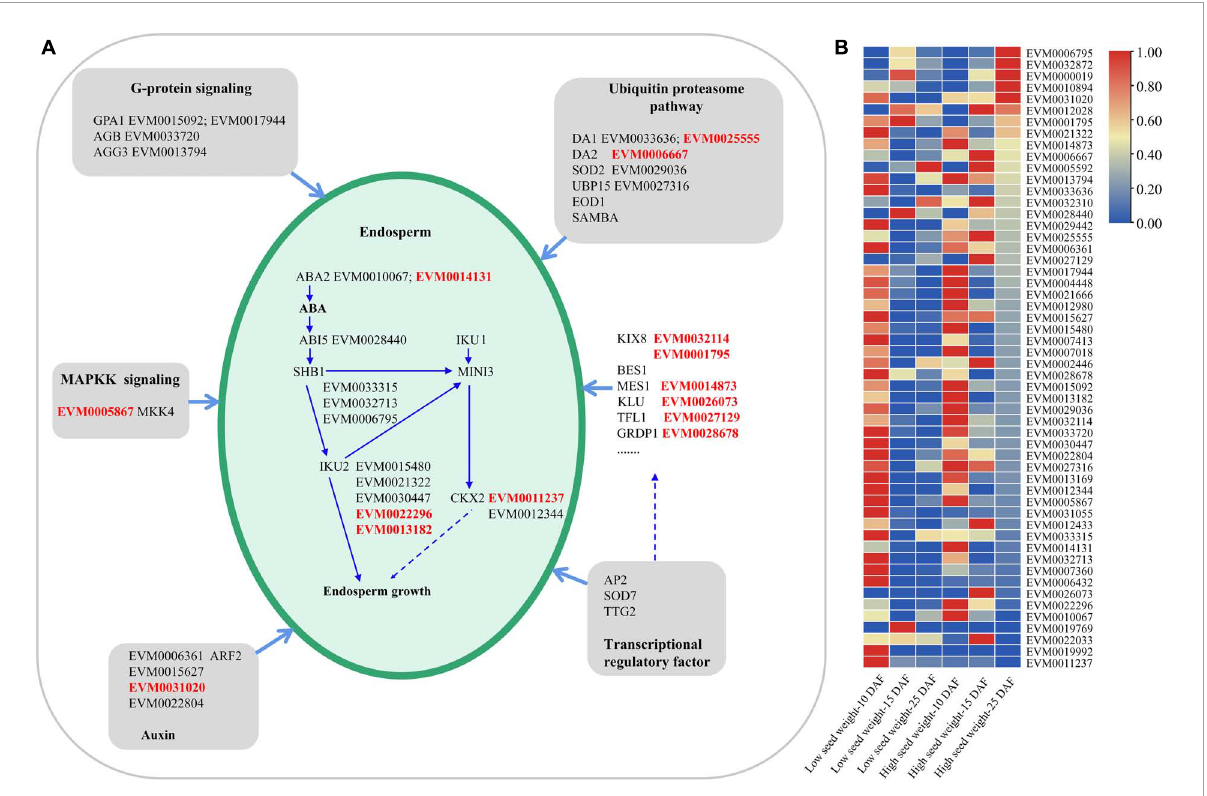
FIGURE6 The seed development pathway in mungbean (A) and the expression profiling of 54 candidate genes predicted by comparative genomics, identified in this study (B) . GPA1, G PROTEIN ALPHA SUBUNIT 1; AGB, heterotrimeric G-protein beta subunit; AGG3, heterotrimeric G-protein gamma-subunit; DA1/DA2, a ubiquitin-activated peptides; SOD2, chloroplastic copper/zinc superoxide dismutase CSD2; EOD1, E3 ubiquitin ligase; UBP15, ubiquitin-specific protease; SAMBA, plant-specific negative regulator of the APC/C complex; MKK4, mitogen-activated map kinase; ABA2, ABA DEFICIENT 2; ABI5, ABA INSENSITIVE 5; SHB1, a nuclear and cytosolic protein; IKU1/IKU2, leucine rich repeat (LRR) kinase; CKX2, CYTOKININ OXIDASE 2; MINI3, MINISEED 3; ARF2, auxin response factor; AP2, AP2/EREBP (ethylene-responsive element-binding protein) class of transcription factors ( Figure 5A ). We also identified five transcription factors, three BES1 and two SOD7, transcription repressor involved in regulation of inflorescence architecture; KIX8, KINASE-INDUCIBLE DOMAIN INTERACTING8; MES1, METHYL ESTERASE 1; KLU, cytochrome P450 CYP78A5 monooxygenase. DAF, days after flowering; ABA, abscisic acid; DAF, days after